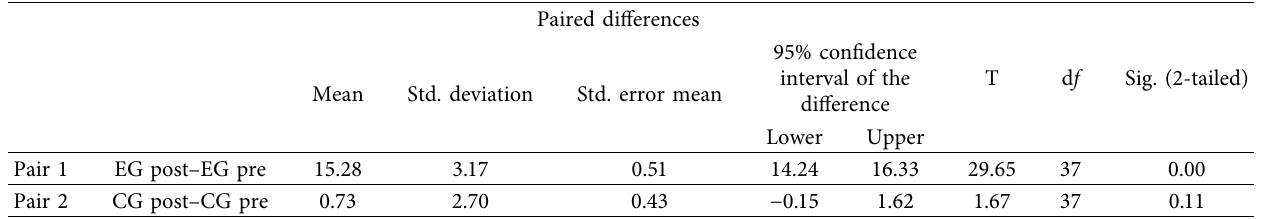
Table 7: Paired samples t -test (pretest and posttest of EG and